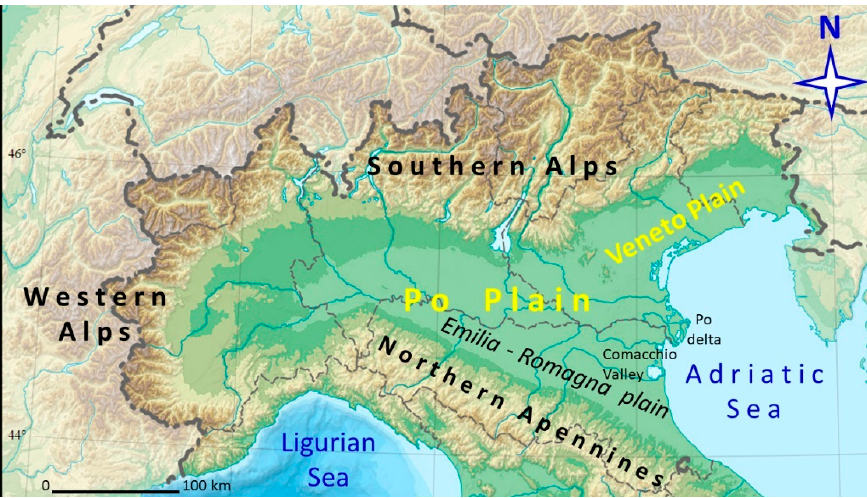
Figure 2. Geographical framework of the Po Plain.